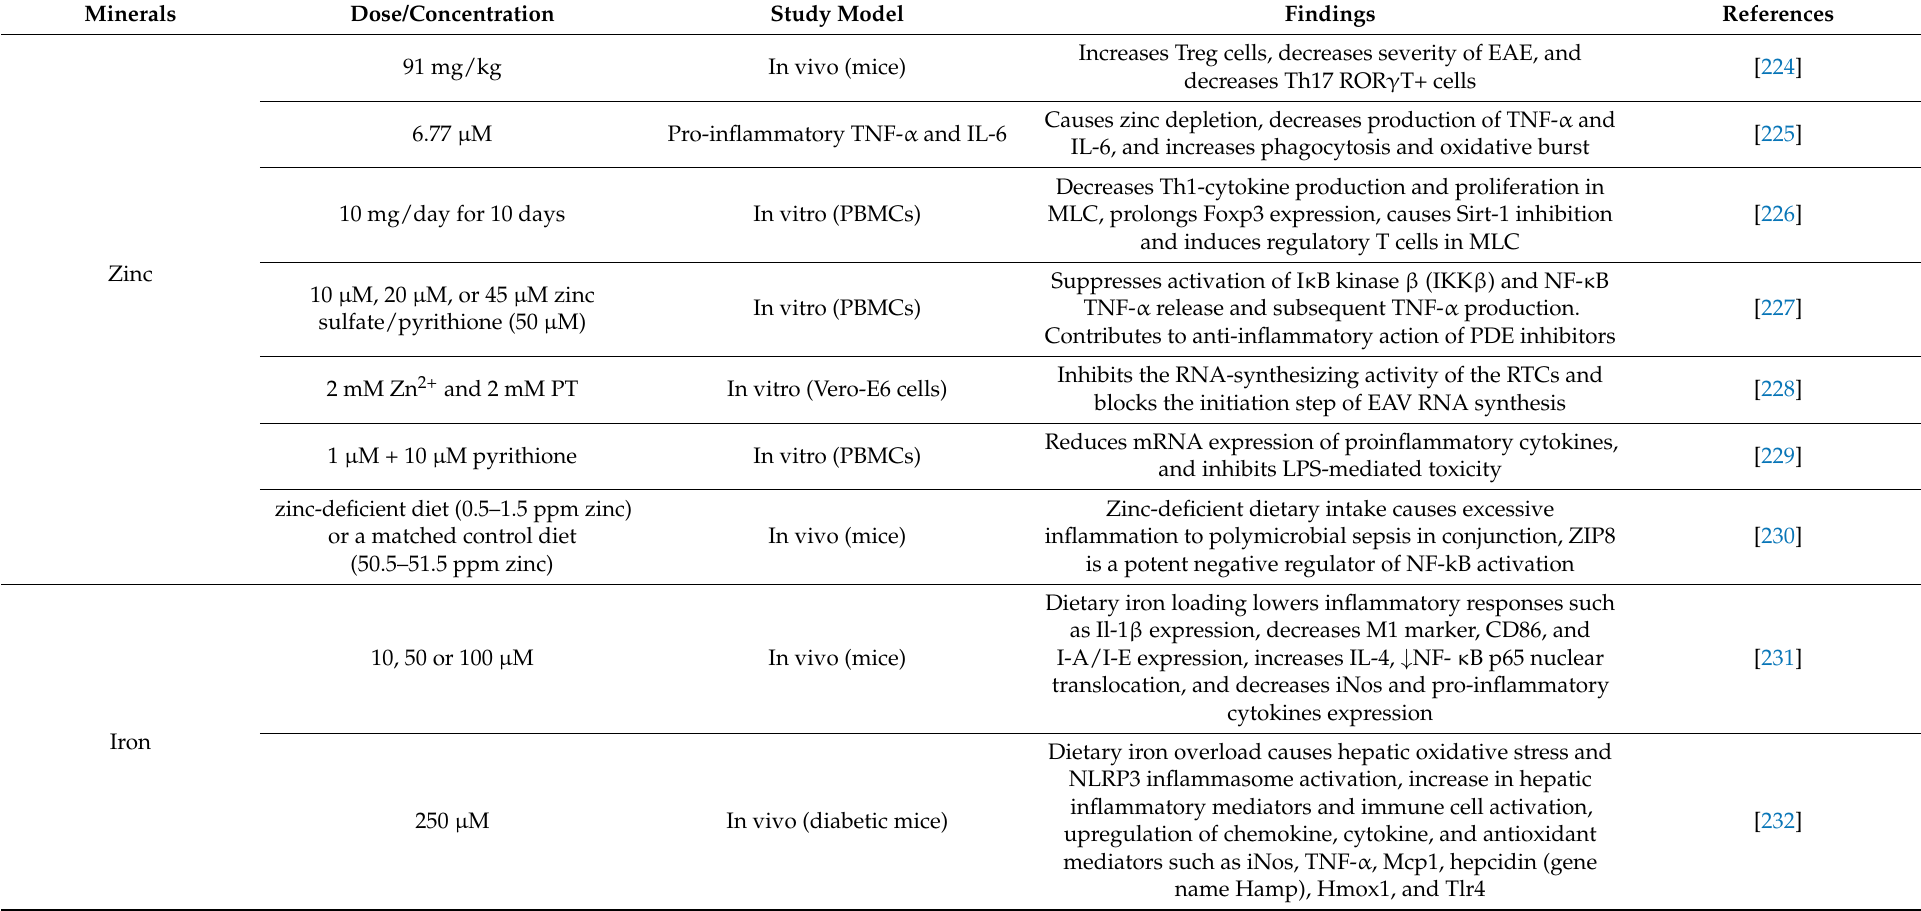
Table 2. The immunomodulatory roles of minerals reported by experimental